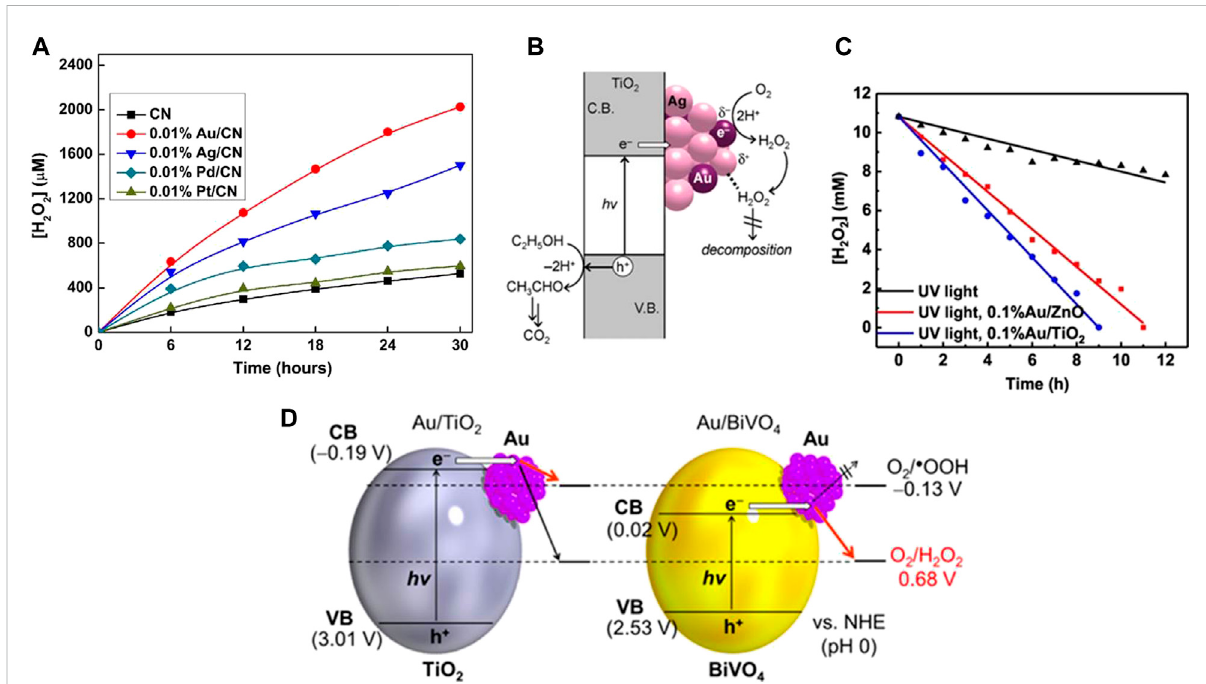
FIGURE 2 (A) Under visible light irradiation ( λ > 420 nm), different noble metal loaded CN photocatalyzed H 2 O 2 activity (Zuo et al., 2019a). (B) Mechanism for photocatalytic production of